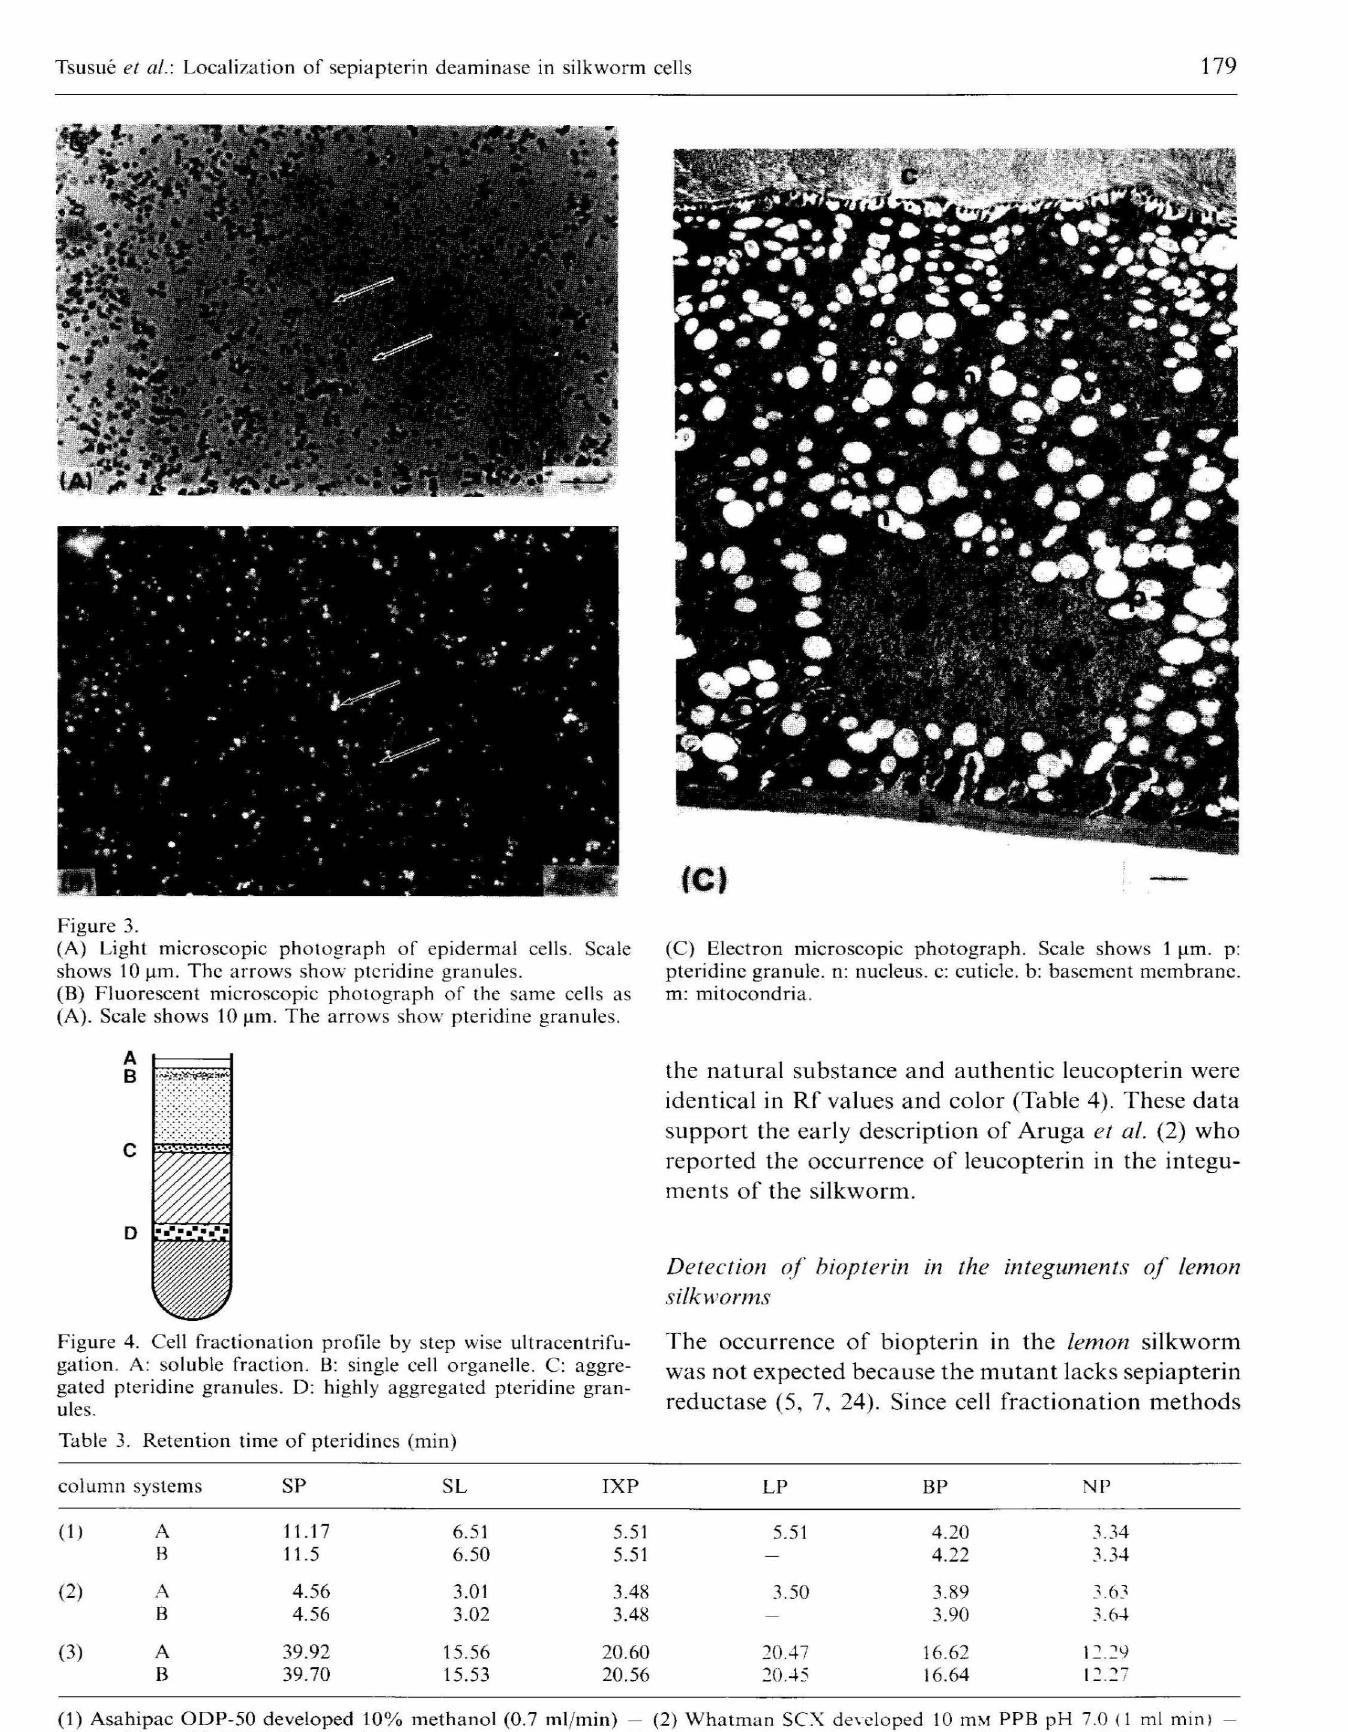
Table 3. Retention time of pteridincs (min) column